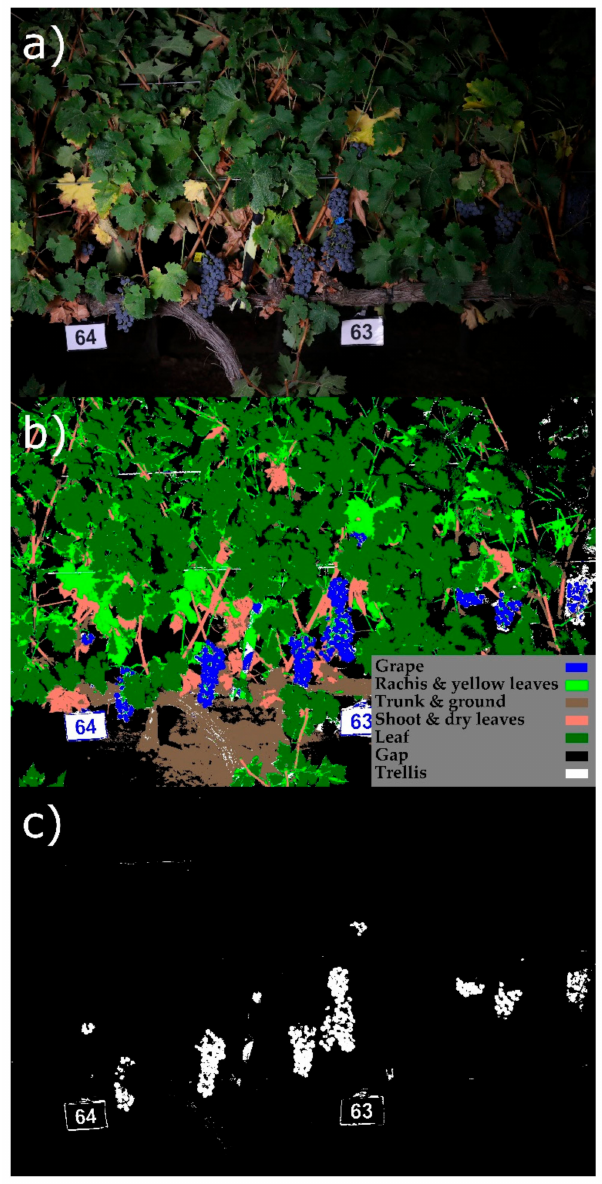
Figure 4. Initial semi supervised segmentation. A set of pixels were manually labeled on the set of the original images ( a ) into seven predefined classes (“grape”, “rachis”, ‘trunk”, “shoot”, “leaf”, “gap”, or “trellis”), and the multinomial logistic regression model performed the segmentation on the whole set of images. ( b ) Some pixels of elements without a predefined class were misclassified (e.g., yellow leaves identified as “rachis”, dry leaves identified as “shoot”, or ground identified as “trunk”). The pixels classified as “grape” and marked in white ( c ) were used for identifying cluster